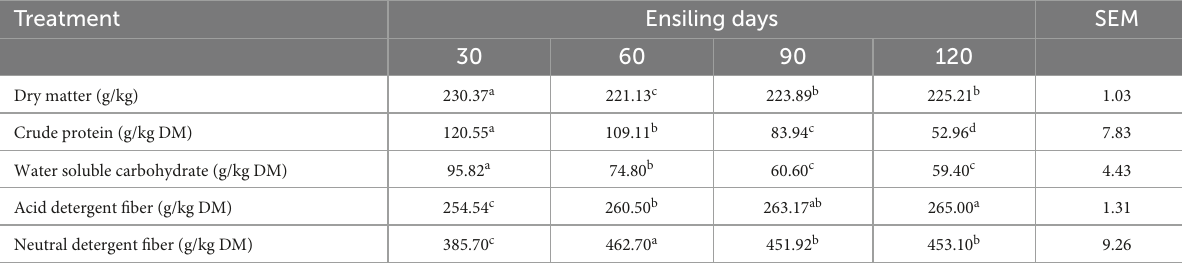
TABLE 3 Chemical composition after ensiling.